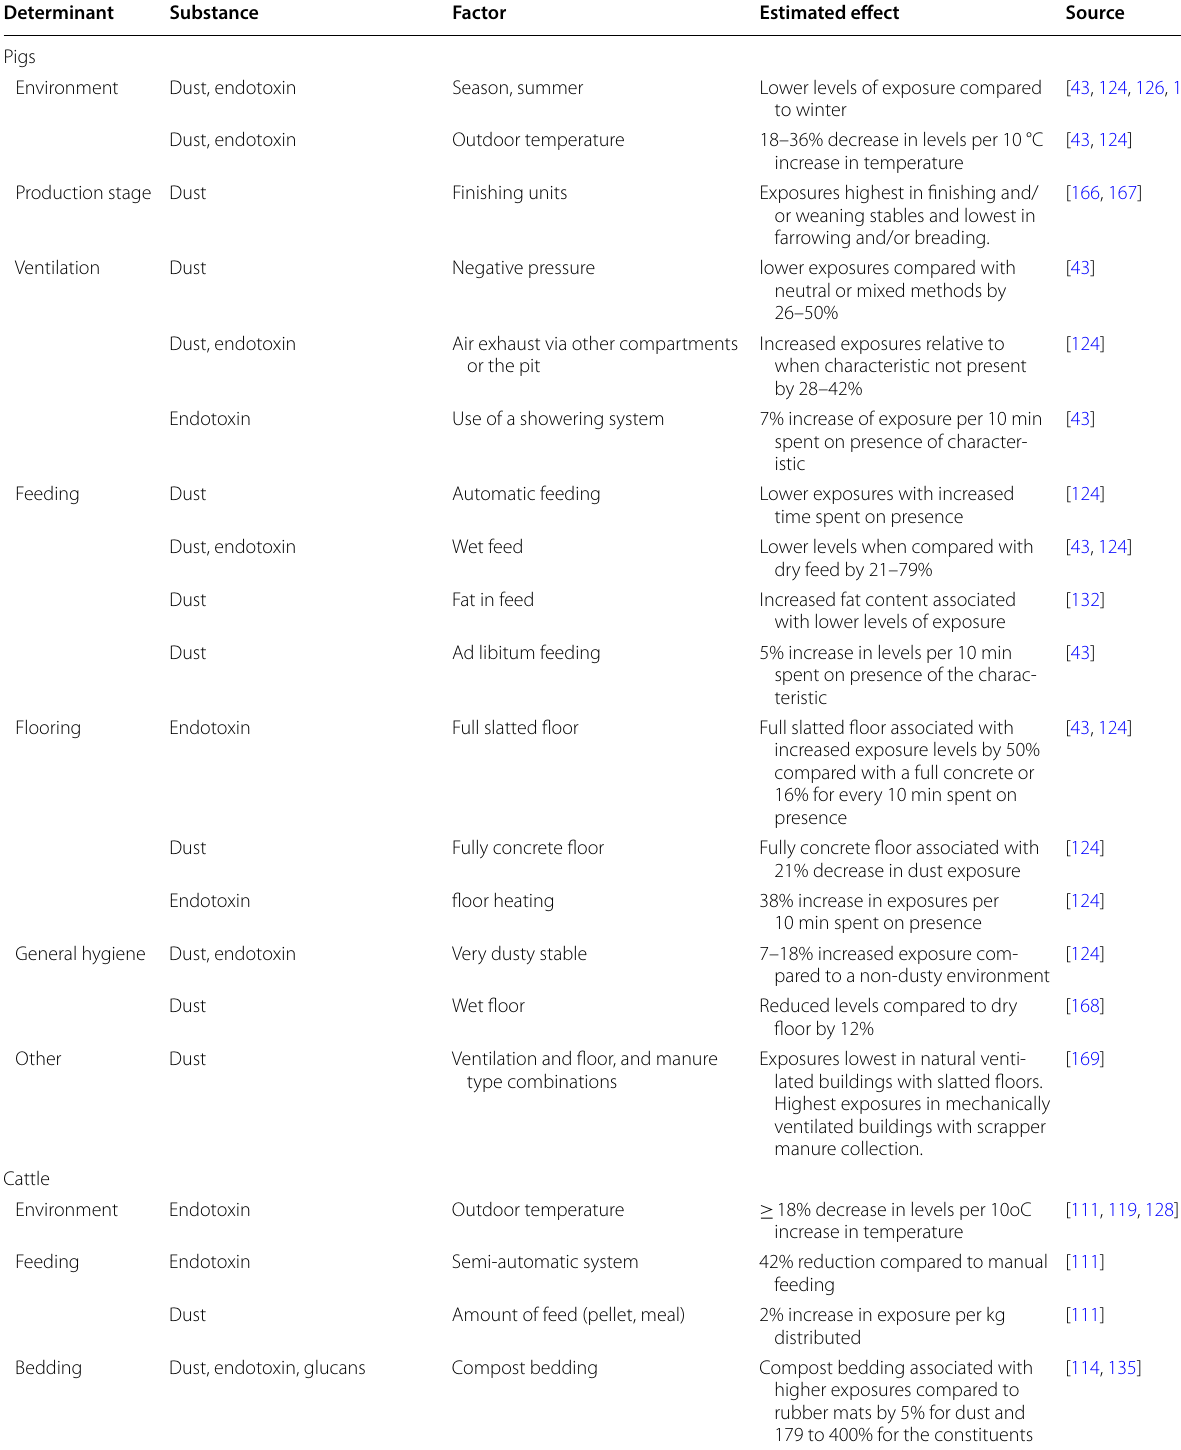
Table 6 Literature reported engineering and production parameters affecting personal exposures of farmers to bio-